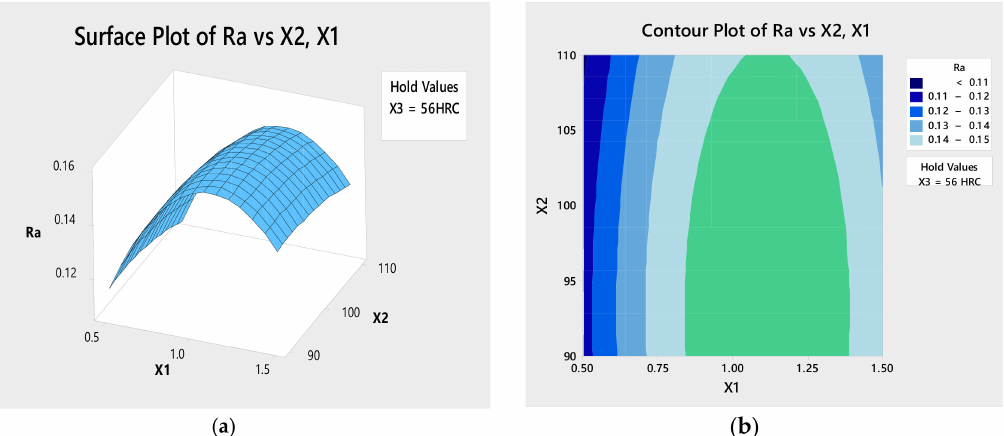
Figure 4. The e ff ects of nano concentration and cutting speed on surface roughness R a . ( a ) Surface plot of R a versus cutting speed and nano concentration; ( b ) Contour plot of R a versus cutting speed and nano concentration.